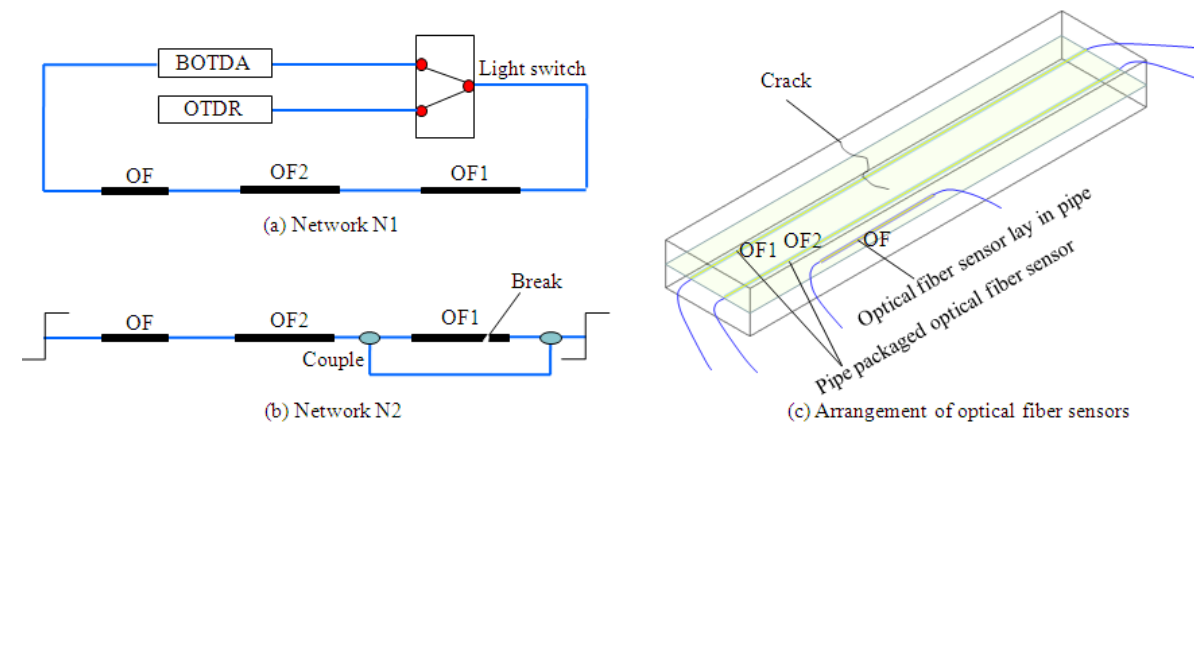
Figure 20. Design and application of primary self-healing network in cement